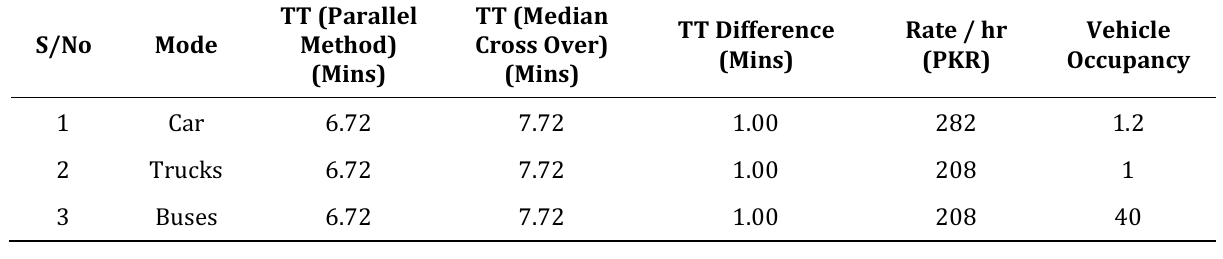
Table 2. Travel Time Difference between Parallel and Median Cross-Over Method